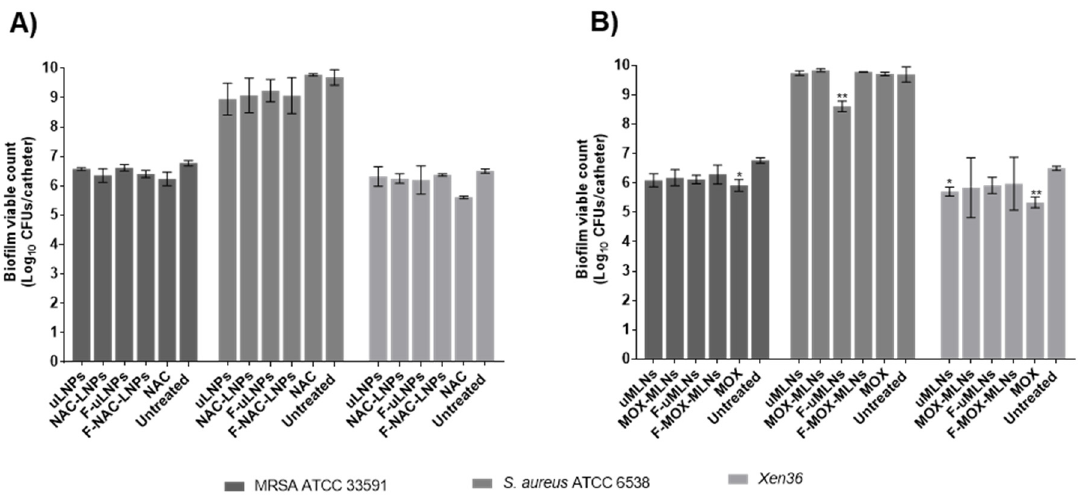
Figure 7. Biofilm viable count of the strains MRSA ATCC 33591, S. aureus ATCC 6538, and Xen36 grown in vitro for 24 h in catheters, after a 24 h treatment with different nanosystems. ( A ) The unloaded and NAC-loaded LNPs were tested at a concentration of 2 mg mL − 1 (corresponding to a NAC concentration of 0.9 mg mL − 1 ). Free NAC was tested at the same concentration. ( B ) The developed MLNs and free MOX were tested at a MOX concentration of 0.5 µg mL − 1 . Untreated biofilms were used as a positive control, and TSB 0.6x supplemented with 0.2% ( w/v ) glucose was used as a negative control. The values are presented as the mean ± SD for three catheters. * p < 0.05, ** p < 0.01, relative to the untreated biofilms. Statistical analysis: two-way ANOVA, Dunnett’s multiple comparisons test.